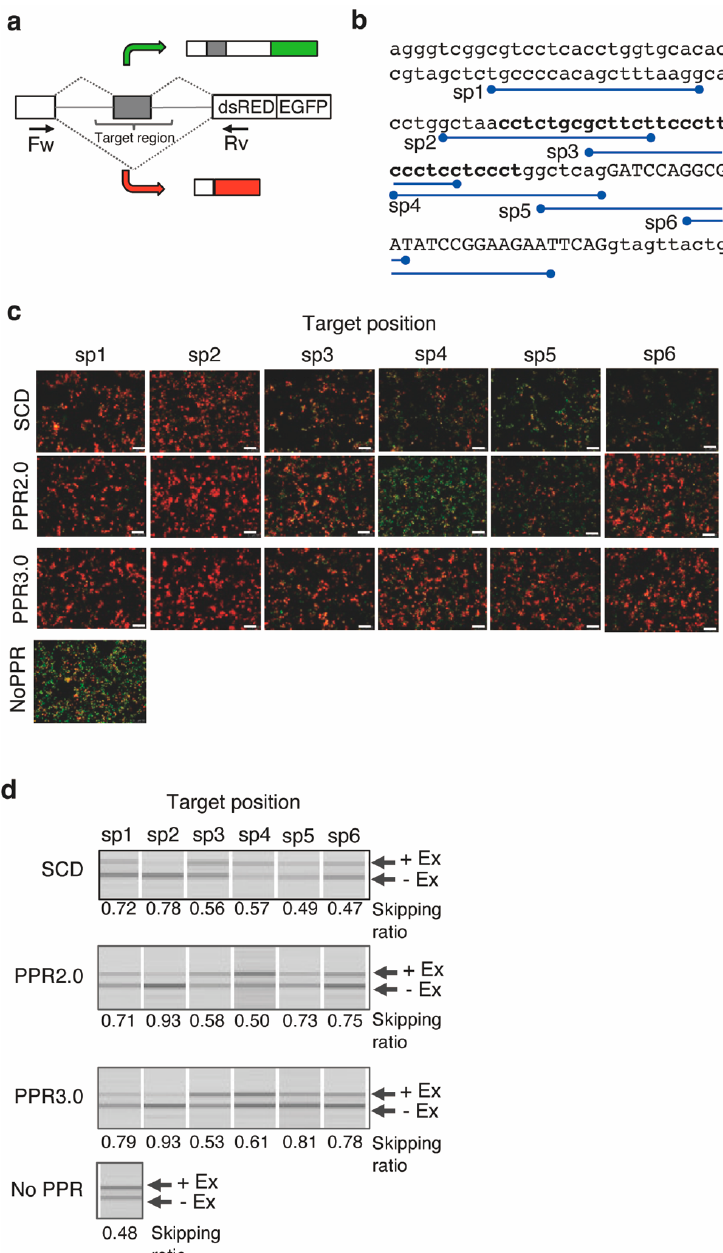
Figure 4. A reporter assay for splicing control by designer PPR proteins. ( a ) Diagram of the reporter system RG-6. The bi-chromatic alternative splicing reporter transcribes RNA containing the EGFP or dsRED coding frame in the presence or absence of exon 2. ( b ) Sequence of the target region. The positions of the target sequences (sp1–6) for the designer PPR proteins are depicted. The exons and introns are shown by uppercase and lowercase letters, respectively. The polypyrimidine tract is highlighted using bold letters. ( c ) Cell image analysis for the splicing control. Merged fluorescent images of GFP and dsRED show the designer PPR proteins of the SCD, PPR2.0, or PPR3.0 scaffolds transfected into HEK293T cells with RG-6 reporter plasmids. The control experiment was performed without transfection of the PPR gene. The white bar indicates 10 µ m. ( d ) RT-PCR analysis of the splicing variants. The extent of alternative splicing (presence or absence of exon 3; +Ex, − Ex) was analyzed using RT-PCR with forward and reverse primer sets, as shown in ( a ). The skipping ratio was estimated by calculating the signal intensity of [ − Ex]/([+Ex] + [ −